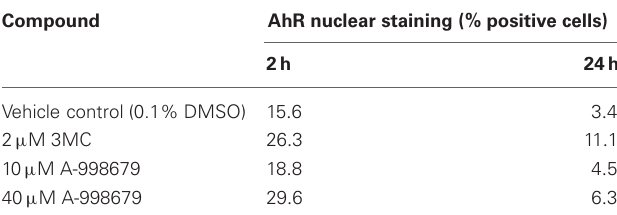
Table 1 | Quantitation of AhR nuclear translocation in HepG2 Cells. Compound AhR nuclear staining (% positive cells) 2h 24h Vehicle control (0.1% DMSO) 15 .